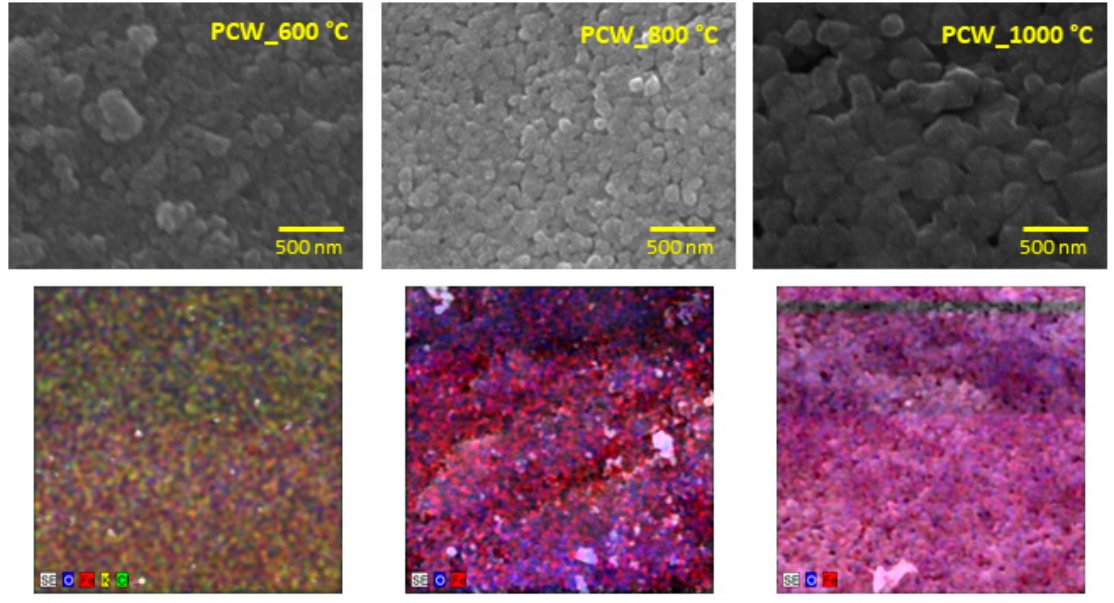
Figure 7. Surface morphology, by SEM, of the samples heat-treated at 600, 800, and 1000 °C, where the grains reach the nanoparticles’ size ( upper figures ); EDS mapping detects oxygen ( blue color ) and iron ( red color ) elements for all samples; potassium ( yellow color ) and chlorine ( green color ) are detected just for PCW_600°C ( bottom figures ).